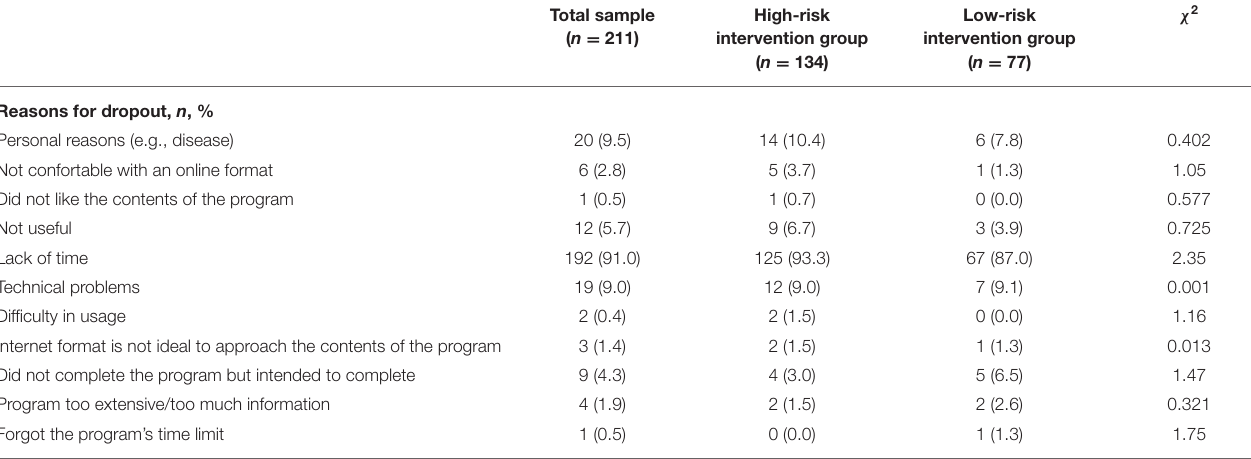
TABLE 3 | Participants’ reasons for not completing Be a